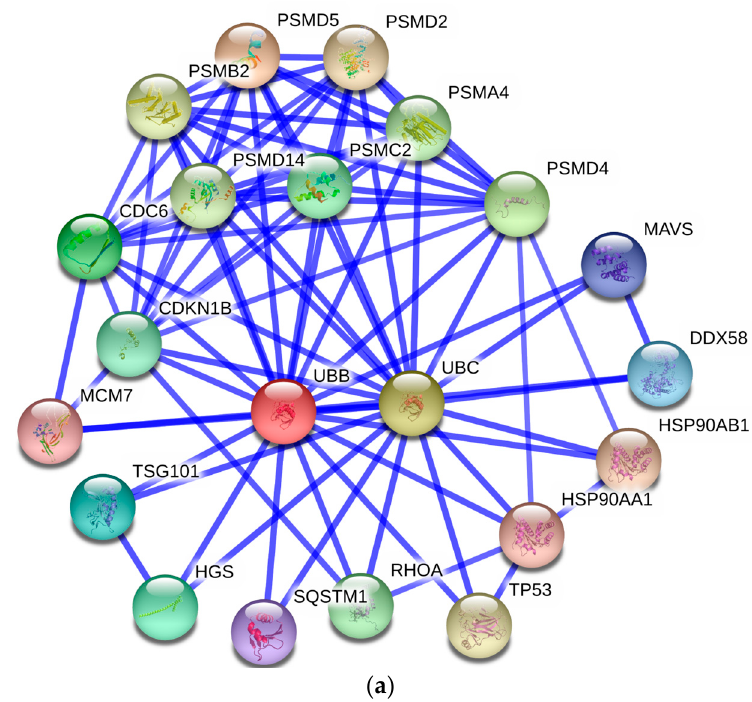
Figure 7. Cont. Figure 7.